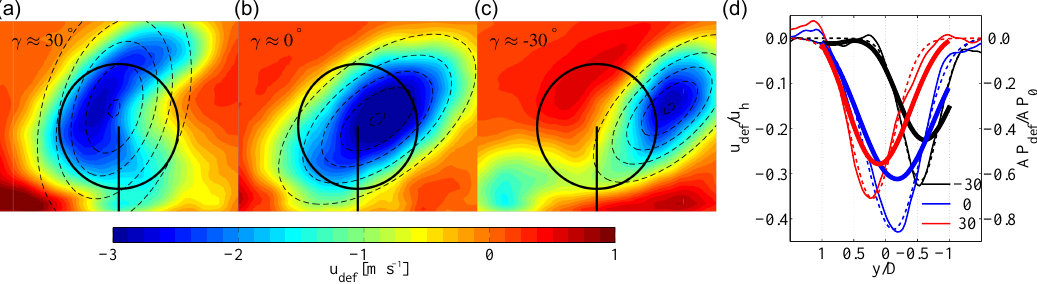
Figure 9. Same as in Fig. 5 but for the SBL simulation.